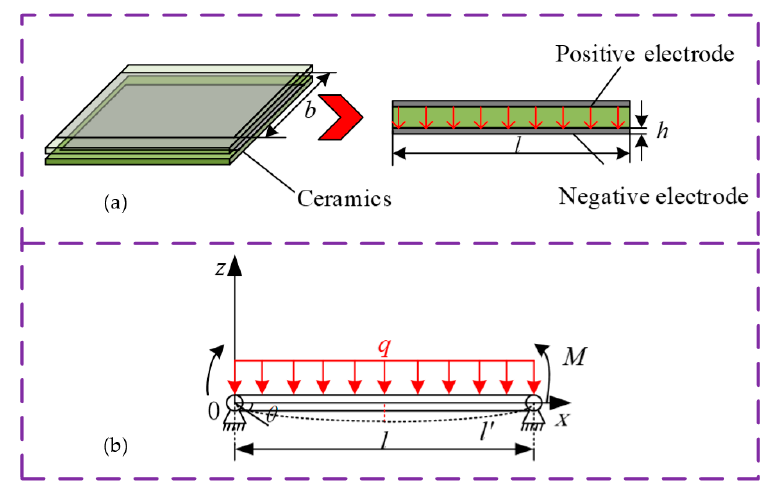
Figure 7. Equivalent diagram of the inner electrode: ( a ) schematic diagram of the electrode; ( b ) Figure7. Equivalentdiagramoftheinnerelectrode: ( a )schematicdiagramoftheelectrode; ( b )schematic schematic diagram of electrode equivalent mechanical model. diagram of electrode equivalent mechanical